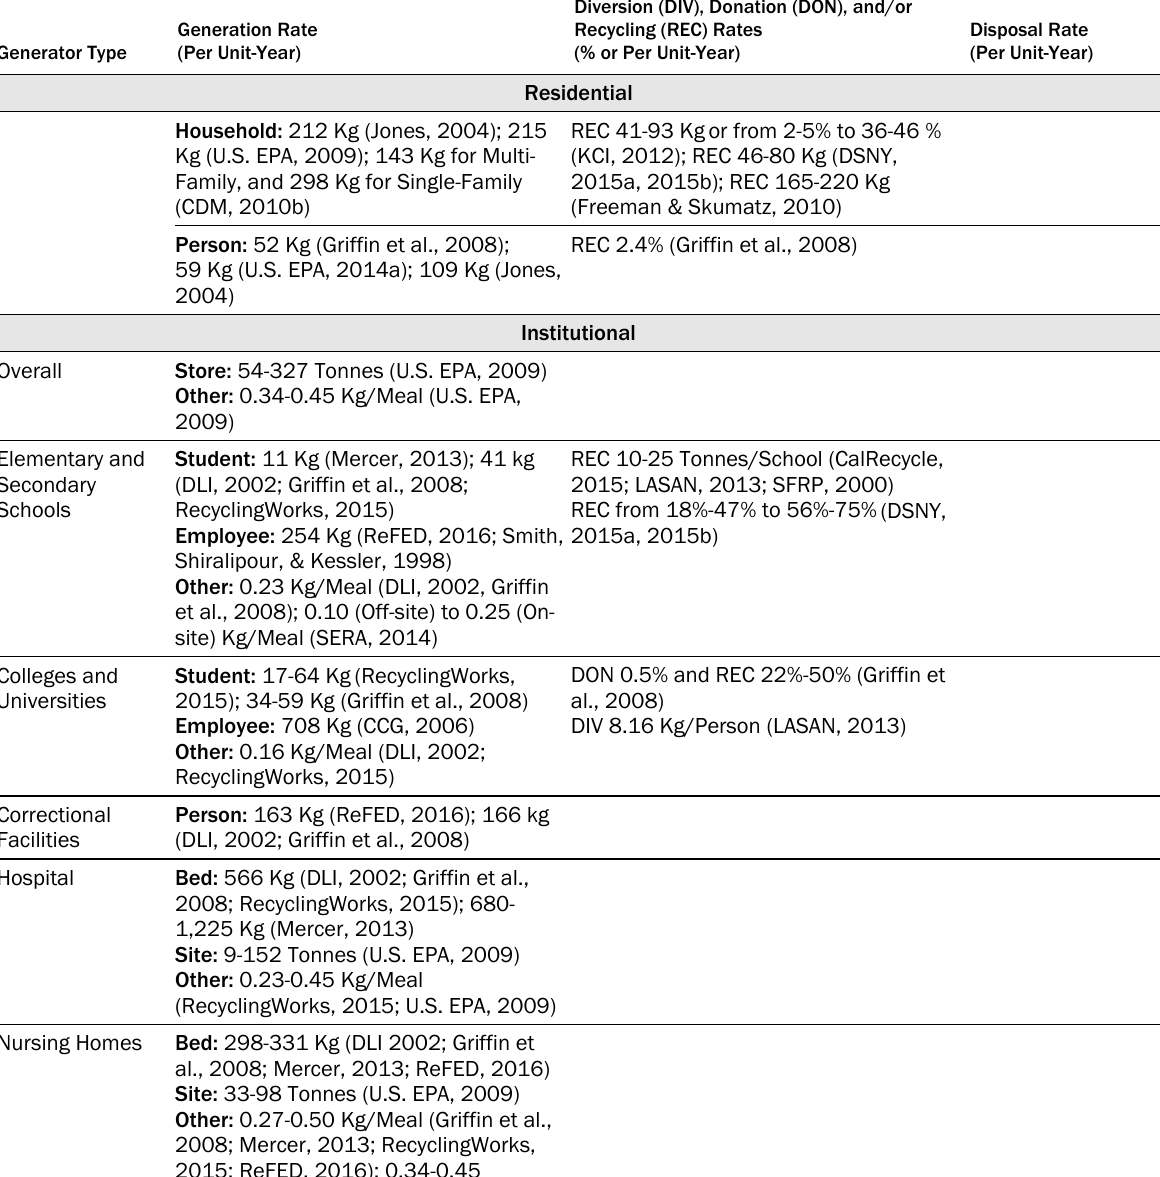
Table 1. Review on Food Waste Parameters by Generator Type (continued)